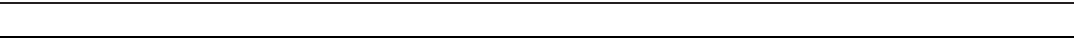
PICU, Pediatric Intensive Care Unit; PRW, Pediatric Respiratory Ward. Values in bold and underline indicate statistical significance (p , 0.05). 1 p value Fisher’s exact = 0.001.